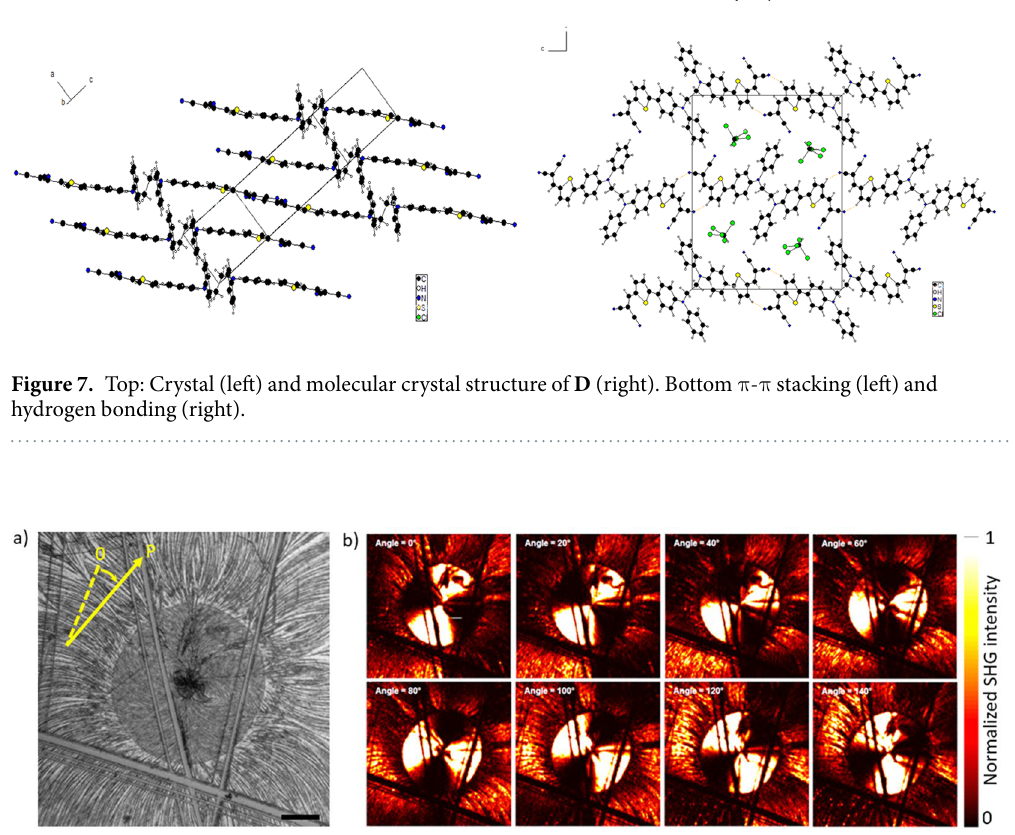
steps of 20 deg. Scale bar: 100 μ m.